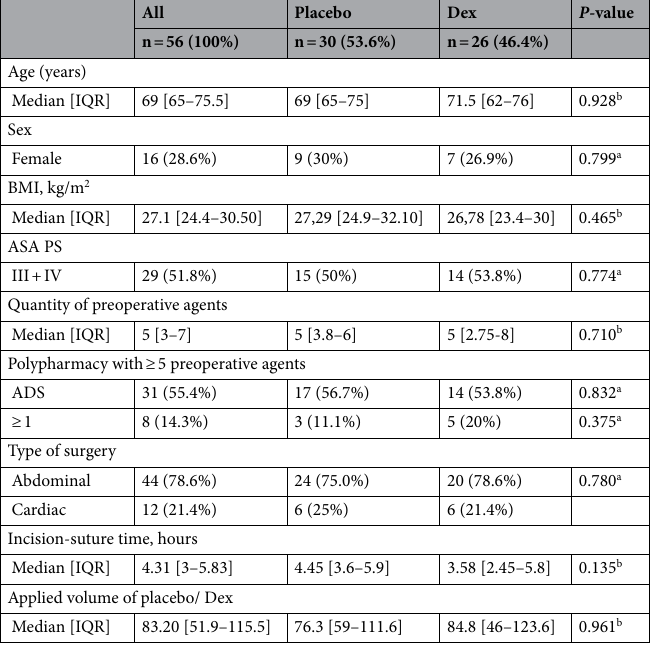
Table 1. Baseline characteristics of 56 patients. Statistical analysis was conducted between patients receiving standard general anaesthesia (Placebo) and dexmedetomidine in addition to general anaesthesia (Dex). ASA PS American Society of Anaesthesiology Physical Score, BMI Body Mass Index, ADS anticholinergic drug scale of preoperative long-term medications, Dex dexmedetomidine, IQR interquartile range. a Categorical variables analysed by Chi 2 test. b Continuous variables analysed by Mann–Whitney U